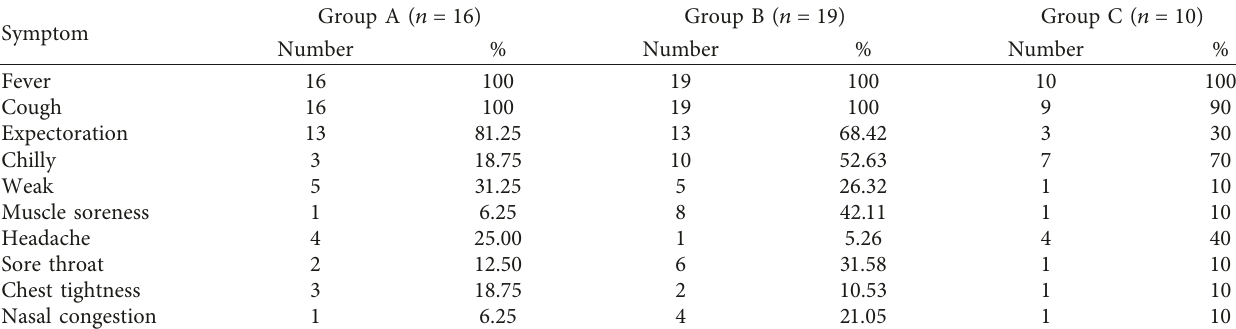
Table 1: Comparison of influenza symptoms in the three